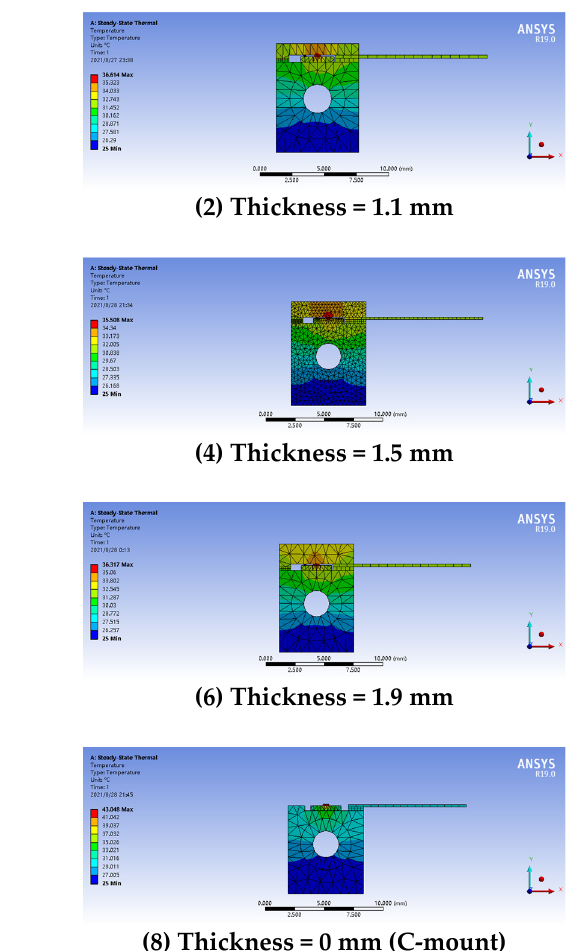
( b ) Figure 7. C-type and DC-type package temperature vector diagrams. ( a ) C-type package tempera- ture vector diagram and ( b ) DC-type package temperature vector diagram. The heat vector distribution diagrams of the two package structures are shown in Figure 7a,b. These diagrams illustrate that, compared to the C-type package structure, the DC-type package structure had bi-directional heat dissipation which increased the heat dissipation range of the laser chip and effectively reduced the heat flow density of the device. This improved the heat dissipation capability of the laser and enhanced the work- ing performance of the semiconductor laser. 2.4. Junction Temperature vs. Power The junction temperatures of devices with different package structures derived from the above finite element analysis vary, according to Equation [19]: (